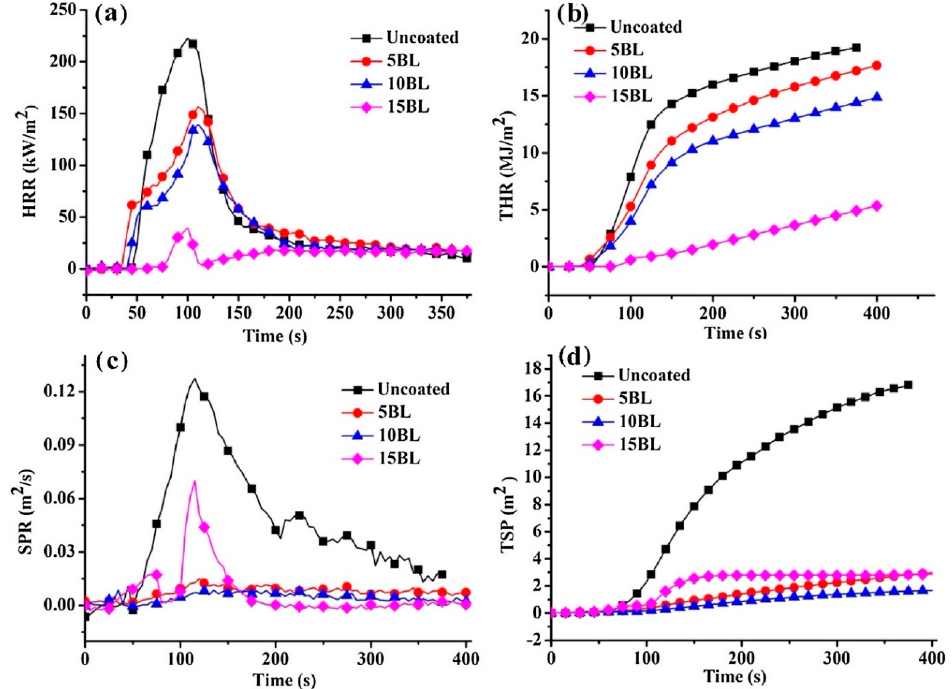
Figure 10. Results from cone calorimetry tests for untreated and LbL-treated cotton fabrics. Heat Release Rate—HRR ( a ), Total Heat Release—THR ( b ), Smoke Production Rate—SPR ( c ) and Total Smoke Production—TSP ( d ) curves. Reprinted with permission from [40]. Copyright 2018, Elsevier.